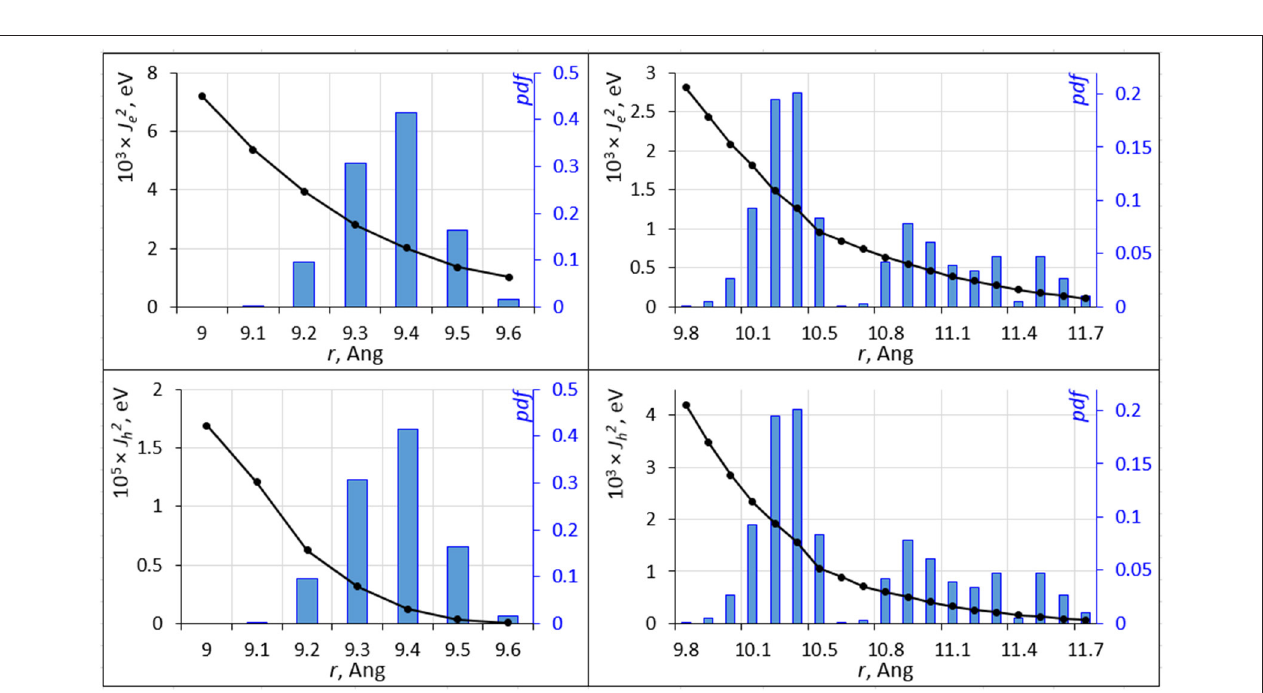
FIGURE 4 | The squared electron transfer integrals (left ordinate axis) for electrons ( J 2 e , top panels) and holes ( J 2 h , bottom panels) for C60 (left panels) and C70 (right panels) are shown as black lines vs. intermolecular distance r . The probability density function ( pdf ) of r is shown as blue histogram (right ordinate axis).